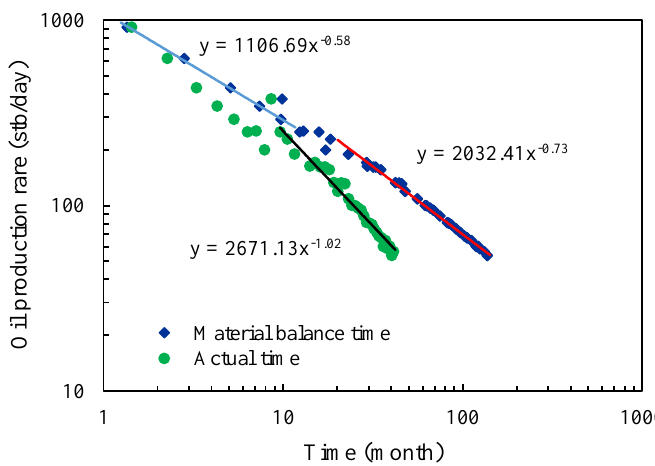
Figure 10. Plot of production rate data for Well #4.